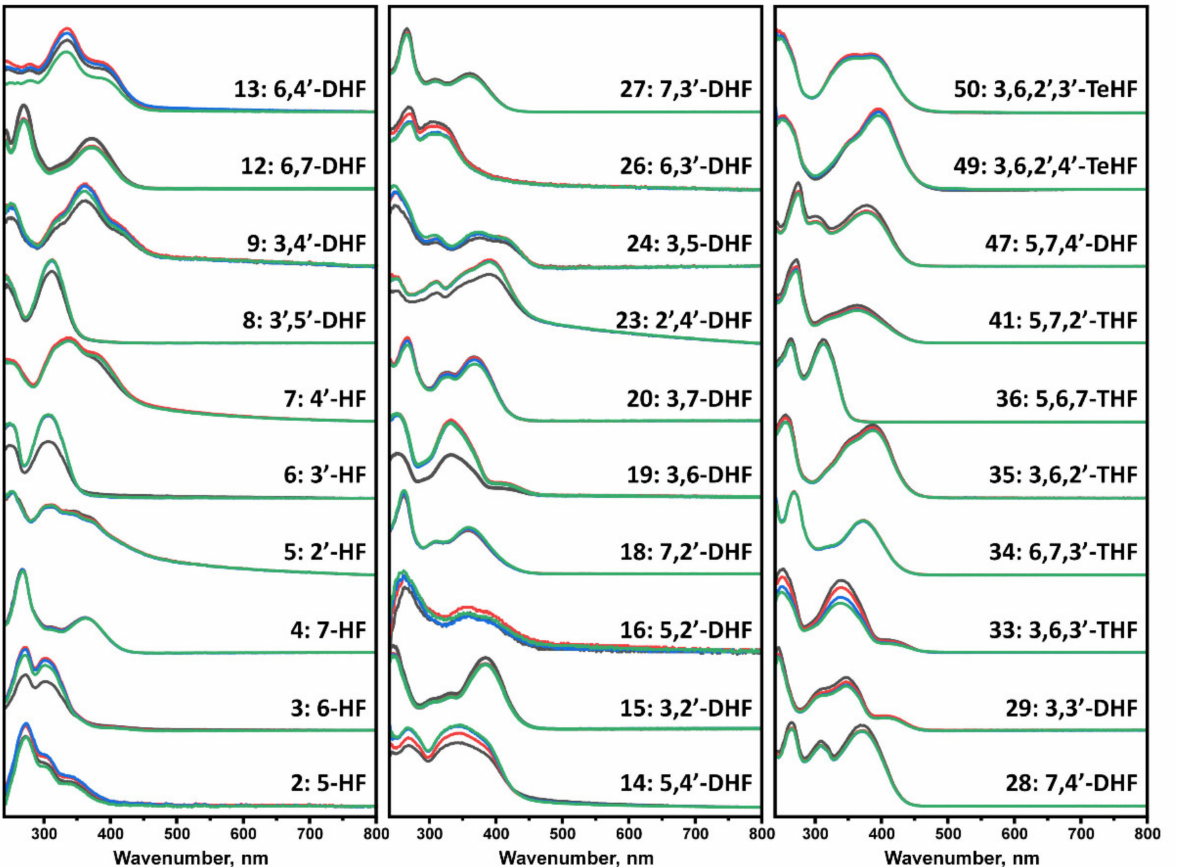
Figure 3. UV-visible absorbance spectra of flavones, recorded at 0 h (black), 5 h (red), 40 h (blue), and 100 h (green). Spectra were baseline corrected at 800 nm. Numbers 3, 6, 13, 14, 19, 23, 33 experienced the most significant decrease in the magnitude of the spectrum, while 4, 18, 27, 34, 36 had no notable change over the course of the